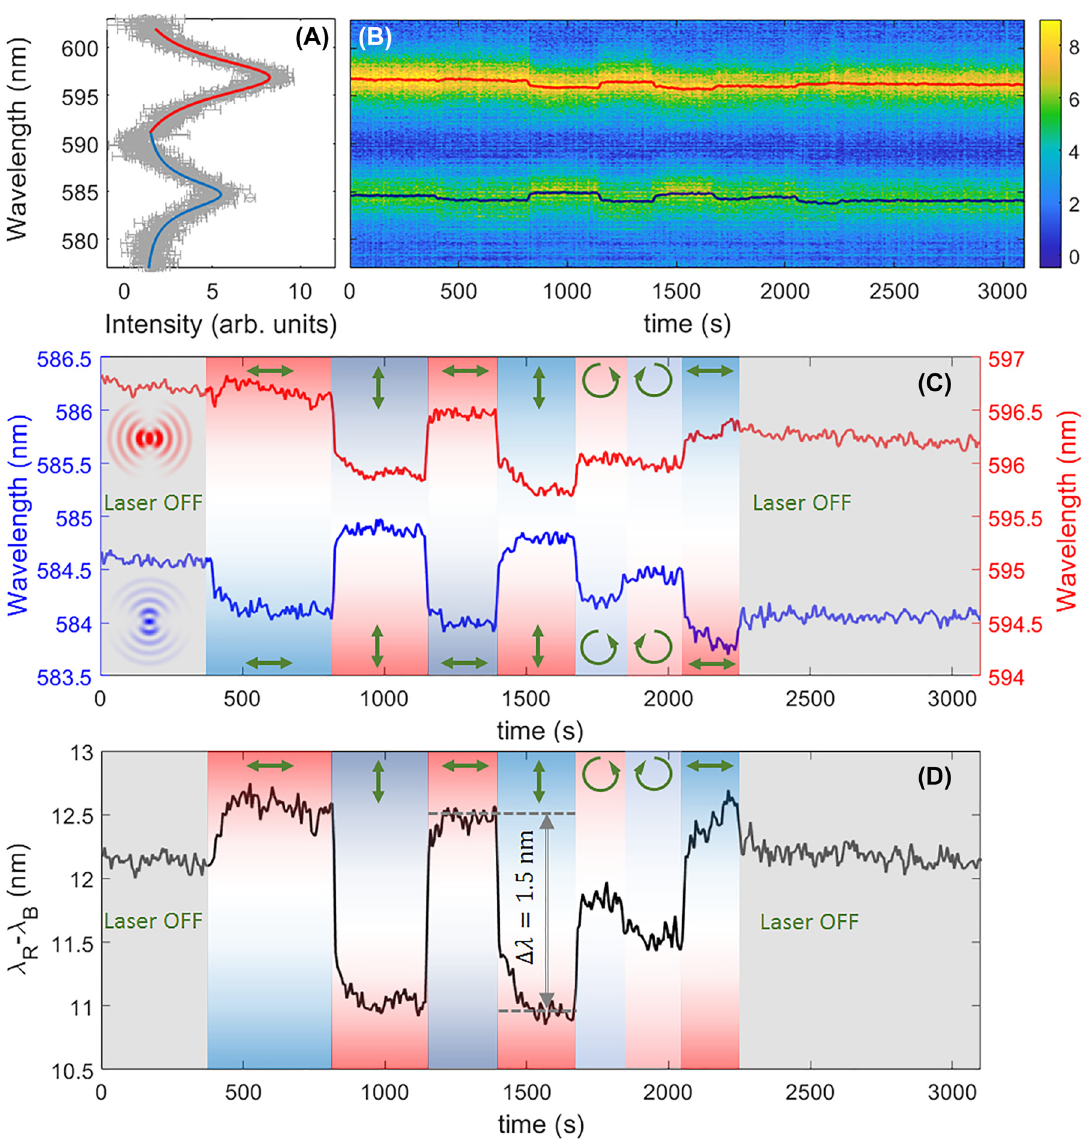
Figure 7: Spectral shift of the BSW cavity modes. (A) Background-subtracted, measured spectral profile of the intensity peaks associated to the ≅ 584.5 nm and the y -polarized mode at 𝜆 ≅ 597 nm. Lorentzian fits are also shown; (B) time evolution of the collected x -polarized mode at 𝜆 B R scattering spectra during laser irradiation; (C) time evolution of the central wavelengths 𝜆 and 𝜆 obtained after fitting. Green arrows indicate the B R polarization state of the illuminating laser: y -oriented (vertical), x -oriented (horizontal), left- or right-handed; (D) time evolution of the relative spectral shift of the orthogonal cavity modes. A tuning over about 1.5 nm spectral range is